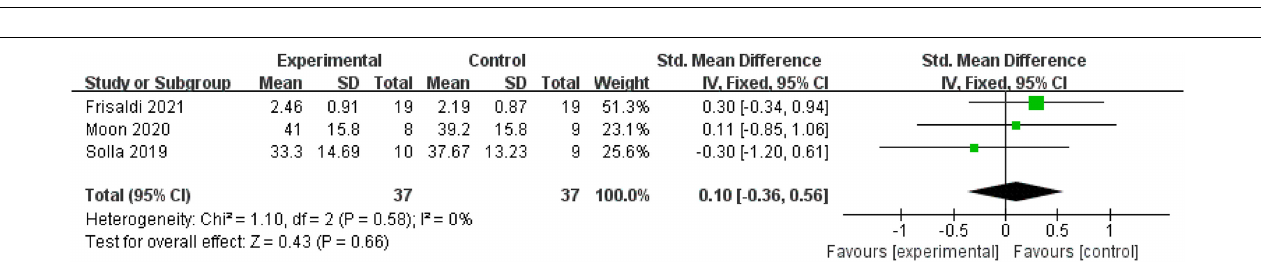
FIGURE 5 | Forest plot showing the effects of mind–body exercises on sleep quality.